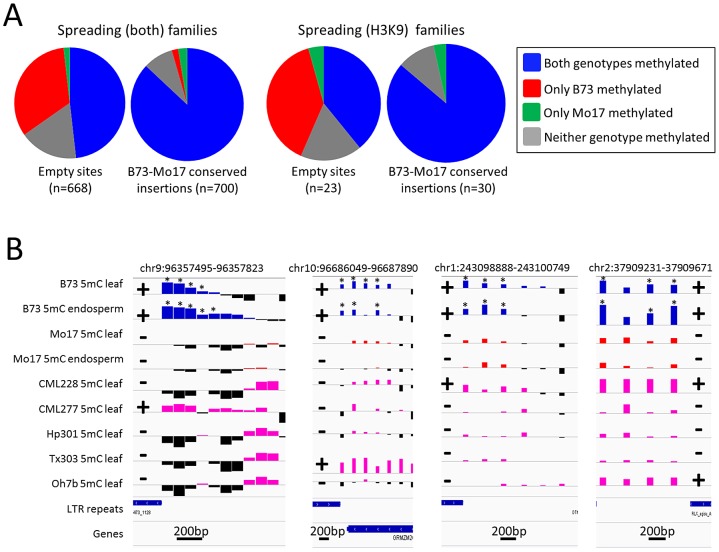
Heterochromatic marks are associated with presence of retrotransposons.(A) Whole genome shotgun sequence data for Mo17 was used to identify retrotransposon insertions that are present within the B73 haplotype but missing in Mo17. The relative level of DNA methylation at the probe nearest the empty site was assessed in B73 and Mo17 for empty sites of spreading (both) and for spreading (H3K9) retrotransposon families. For each set of families we compared the distribution of methylation patterns to a similar number of insertion sites that are conserved in both B73 and Mo17. (B) The DNA methylation levels for four of these “empty” sites (the coordinates specify the retrotransposon present in B73) are shown for two tissues of B73 (blue bars) and Mo17 (red bars) as well as for a single tissue of five other maize genotypes; CML228, CML277, Hp301, Tx303 and Oh7b (pink bars). Black bars for all genotypes indicate depletion of methylation signal. The location of the retrotransposon and its presence or absence are indicated by + or − symbols, respectively. The genotypes containing the insertion of the retrotransposon all exhibit enrichment for DNA methylation while the genotypes without the insertion do not. The “*” indicates probes with significantly (P<0.01) higher DNA methylation levels in B73 relative to the same tissue in Mo17. The horizontal gray line indicates the genome-wide average for each of the modifications. Higher values indicate higher levels of DNA methylation and all plots are show on the same scale for the y-axis. The scale for black line near the bottom of each plot indicates the base pair scale for the x-axis.